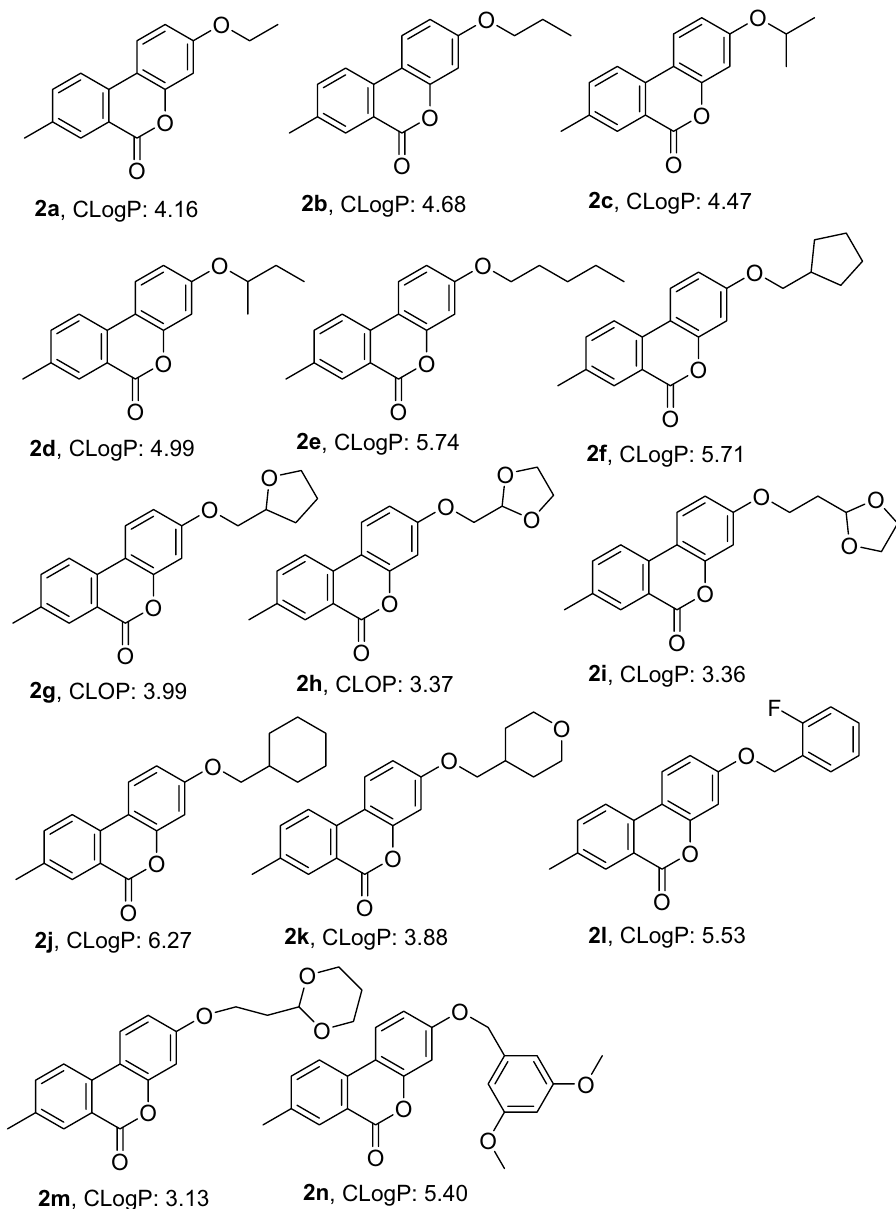
Figure 2. CLoP values of 3-hydroxy-8-methyl-6H-benzo[C]chromen-6-one derivatives